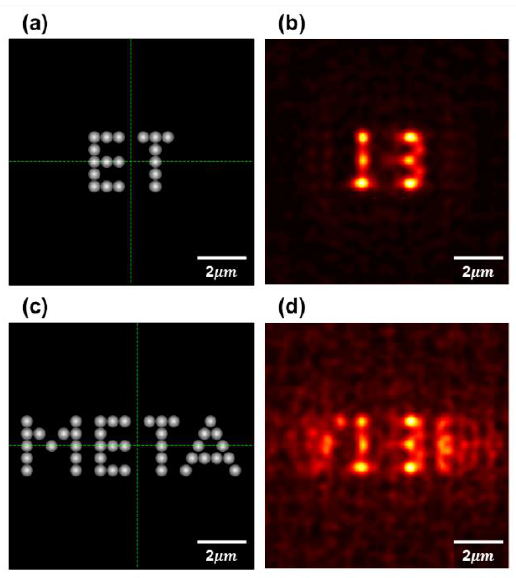
Figure 7. Imaging of large structures composed of multiple incoherent point light